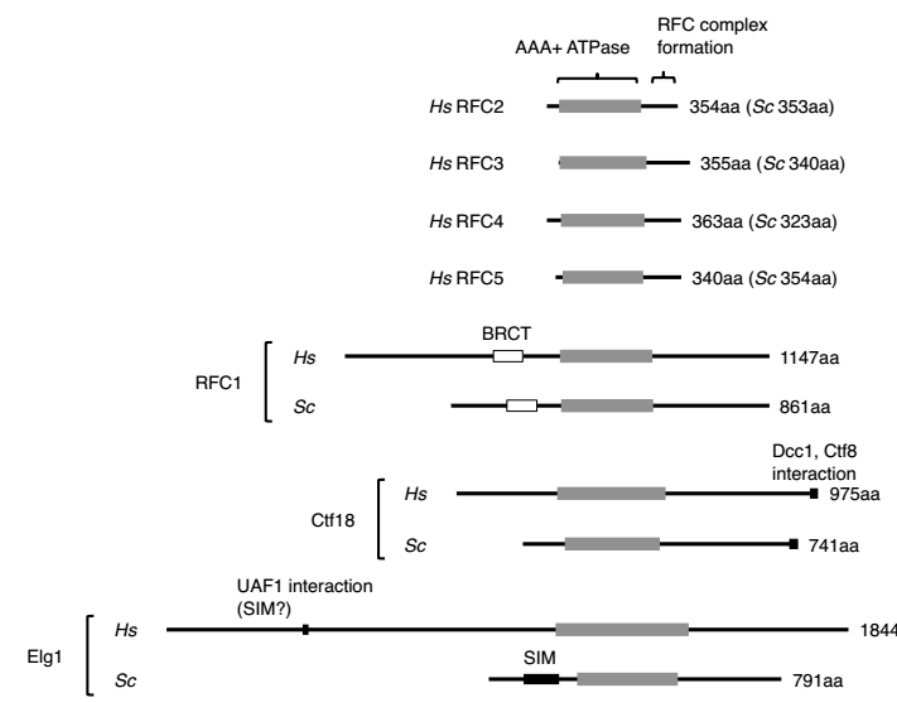
Figure 3. RFC subunit structures. The center of these subunits includes RFC boxes containing a P ‐ loop, which is a general Walker ‐ type ATPase motif. The C ‐ terminal regions following the grey boxes representing the four small subunits (RFC2–5) are required for RFC complex formation. As for the largest RFC subunits, the domains required for complex formation are not well defined. The N ‐ terminal of RFC1 contains a BRCT motif and the C ‐ terminal of Ctf18 contains an interaction motif with Dcc1 and Ctf8. The N ‐ terminal of Elg1 includes a SUMO (in Sc , called SIM) or UAF1 (in Hs ) binding motif, which is potentially involved in PCNA binding. The UAF1 binding motif in Hs Elg1